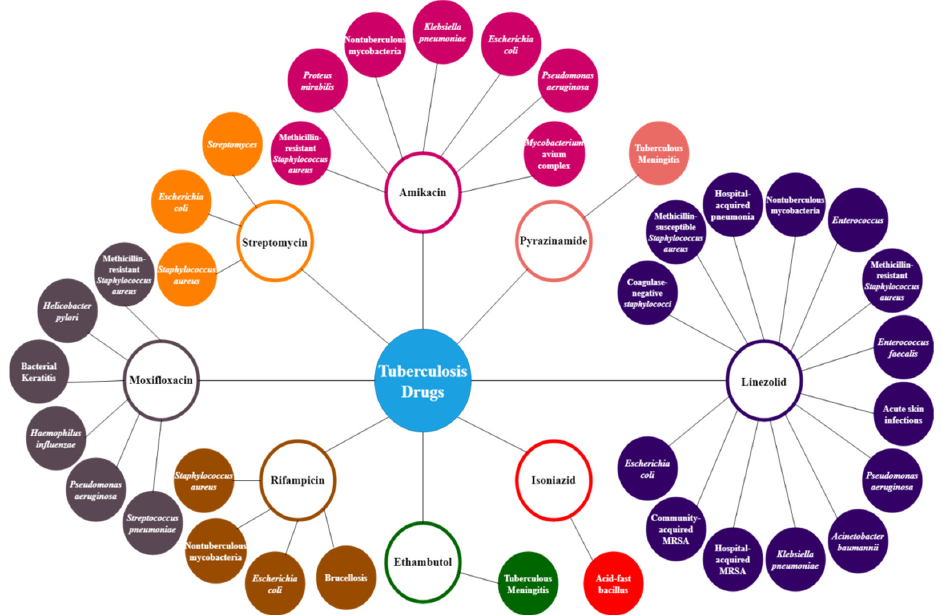
Figure 4. Action of TB drugs against other pathogens or infections.